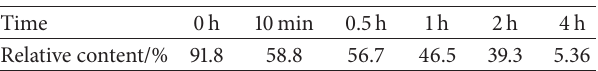
Table 1: Relative contents of fluormica in mixed samples isother- mally heated at 820 ∘ C.